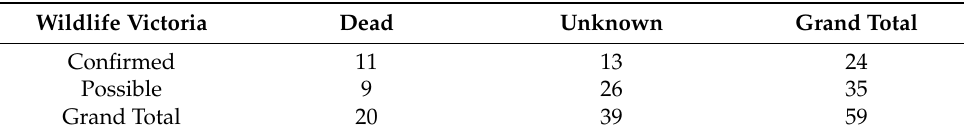
Table 3. The summary of confirmed and possible livestock-related incidents to koalas with their outcomes admitted by Wildlife Victoria from 2007 to 2019. The cases with unknown outcome included koalas sent to hospital without information of the final fate, and those observed injured but unable to catch in the field.